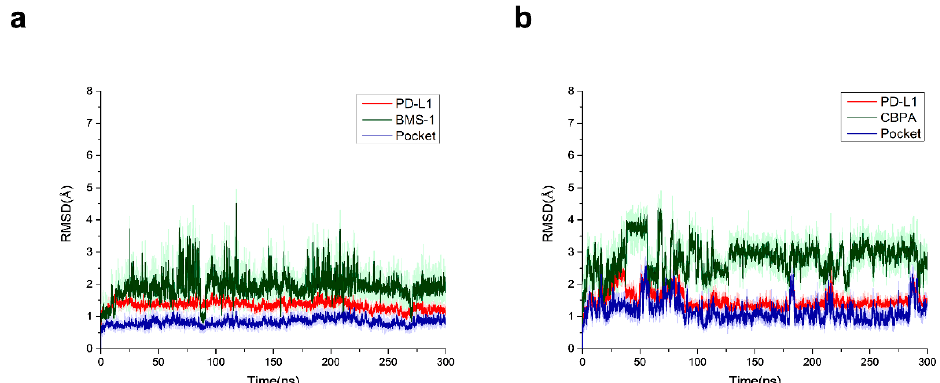
Figure 11. RMSDs of the pocket backbone and the ligands’ heavy atoms in the two systems during MD simulations. ( a ) RMSD of the backbone atoms of the PD-L1 pocket and the heavy atoms of inhibitor 1 (BMS-1). ( b ) RMSD of the backbone atoms of the PD-L1 pocket and the heavy atoms of CBPA. Table 1. Δ G bind for the two inhibitors (inhibitor 1 and CBPA) bound to PD-L1 with the MM/GBSA method (kcal/mol).